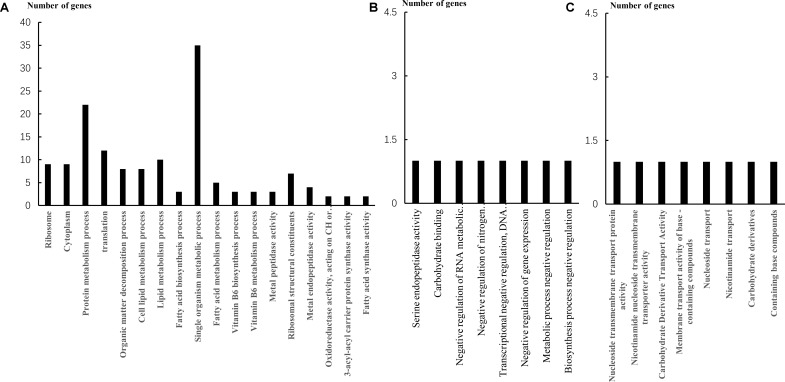
The down expressed genes in three group. (A) Downregulated genes of Vb5 in three categories. (B) Downregulated genes of Vc in three categories. (C) Downregulated genes of biotin in three categories.